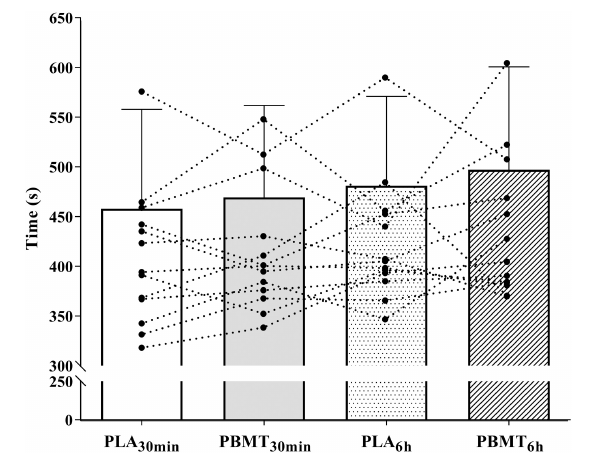
FIGURE 3 | Time until exhaustion in severe-intensity cycling. PBMT 30 min , photobiomodulation applied 30 min before exercise; PLA 30 min , placebo treatment applied 30 min before exercise; PBMT 6 h , photobiomodulation applied 6 h before exercise; PLA 6 h , placebo treatment applied 6 h before exercise n =